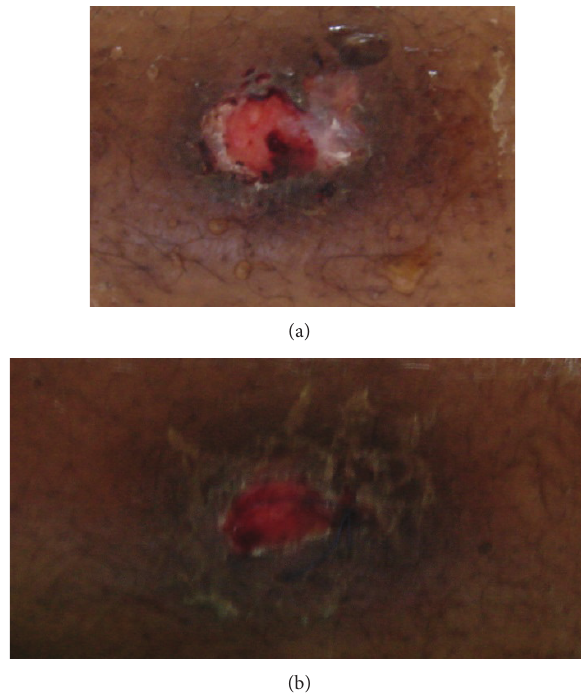
Figure 2: ((a) and (b)) Clinical manifestation of cutaneous tubercu- losis involving the left thigh and showing two lesions, one ulcerated (a) and the other in a healing phase (b).